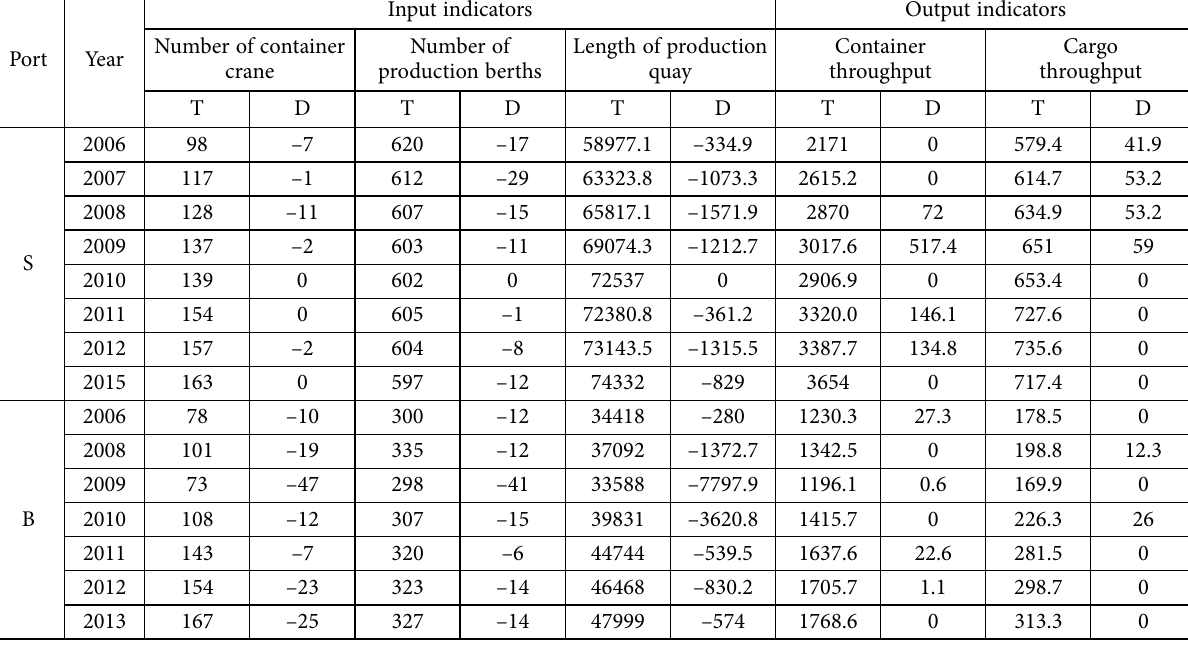
Table 2. Target values of the evaluation indicators of non-efficient